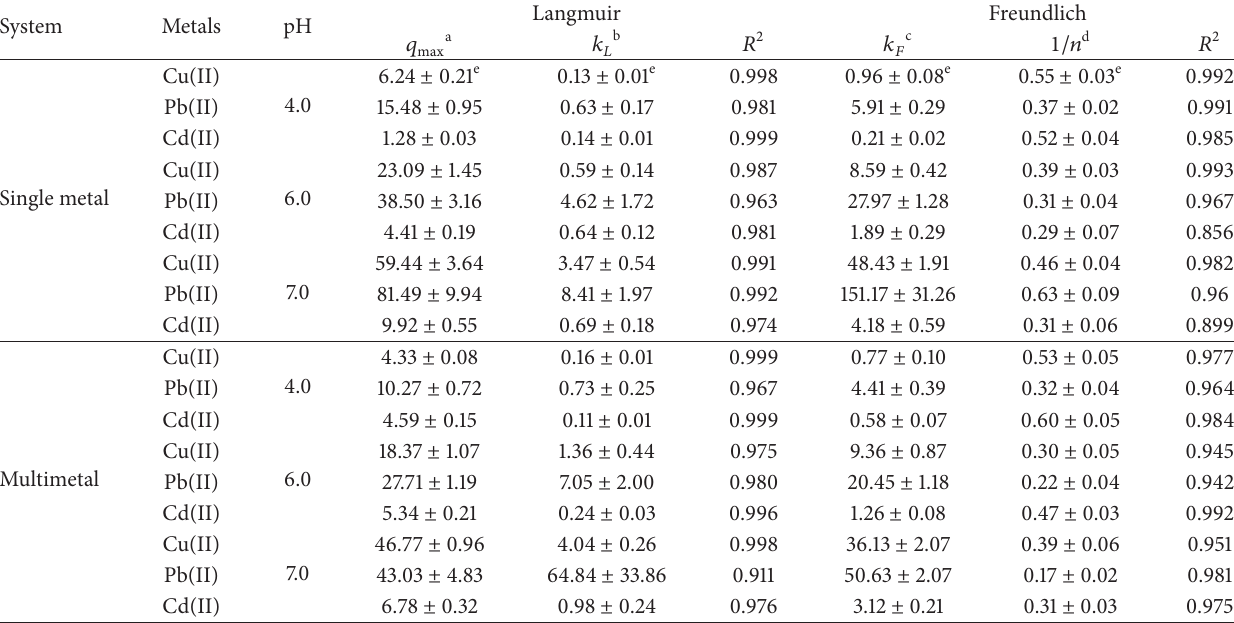
Table 1: Isotherm model parameters of the metal adsorption on the magnetic GO.